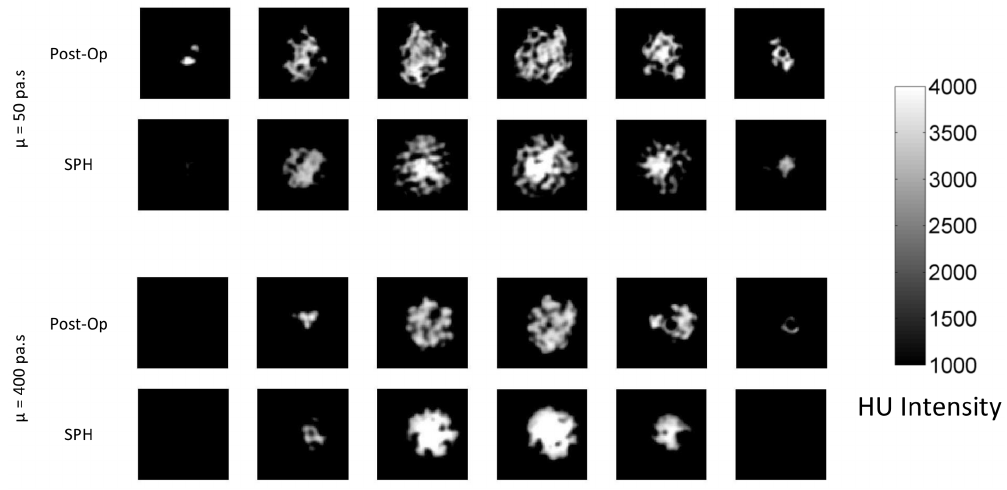
Figure 11. Sample slices taken at 5-mm intervals from the post-operative and simulated CT volumes.